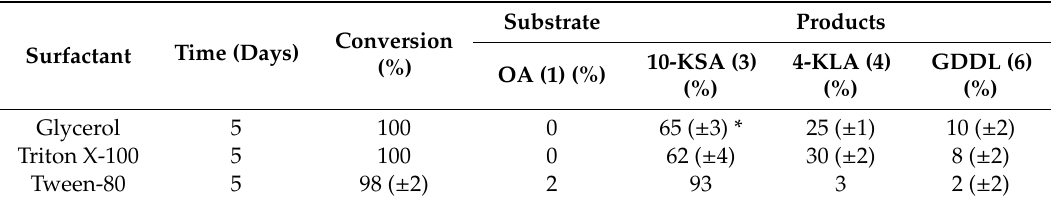
Table 2. E ff ect of surfactant addition (0.1%) on transformation of oleic acid ( 1 ) (1%) catalyzed by Micrococcus luteus PCM525 (in % according to